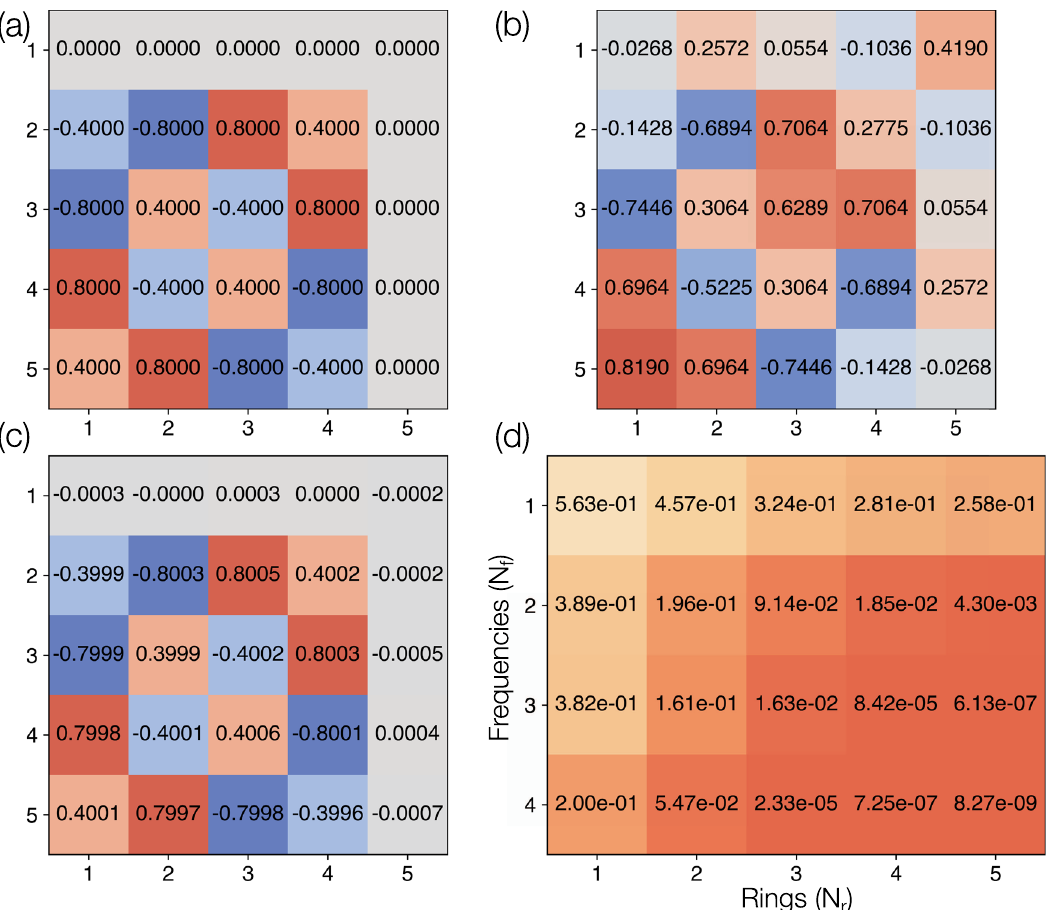
Fig. 5 Implementing elementwise phases of a matrix. a Element-wise phase as a fraction of π of the 5 × 5 Vandermonde matrix implementing the discrete Fourier transform. Element-wise phase achieved by the inverse-design algorithm for b N r = 1 and N f = 4, with a fi delity of 0.8 and global phase of 0.099 π and c N r = 4 and N f = 4, with a fi delity of 1 − 7.25 × 10 − 7 and global phase 0.596 π . d One minus the maximum fi delities achieved by the inverse-design algorithm as a function of N r and N f . A value closer to zero indicates a better performance. Modulation parameters for c are provided in Supplementary Note